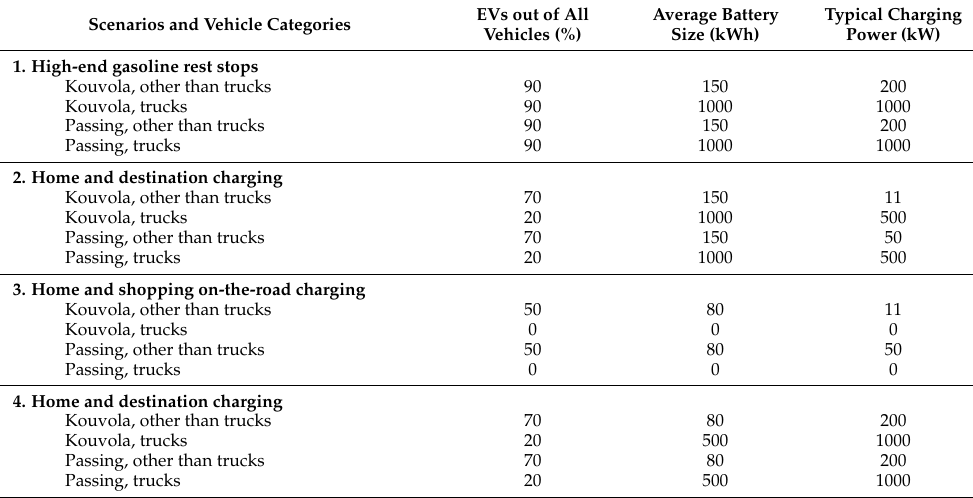
Table 3. Parameters describing the car fleet in different